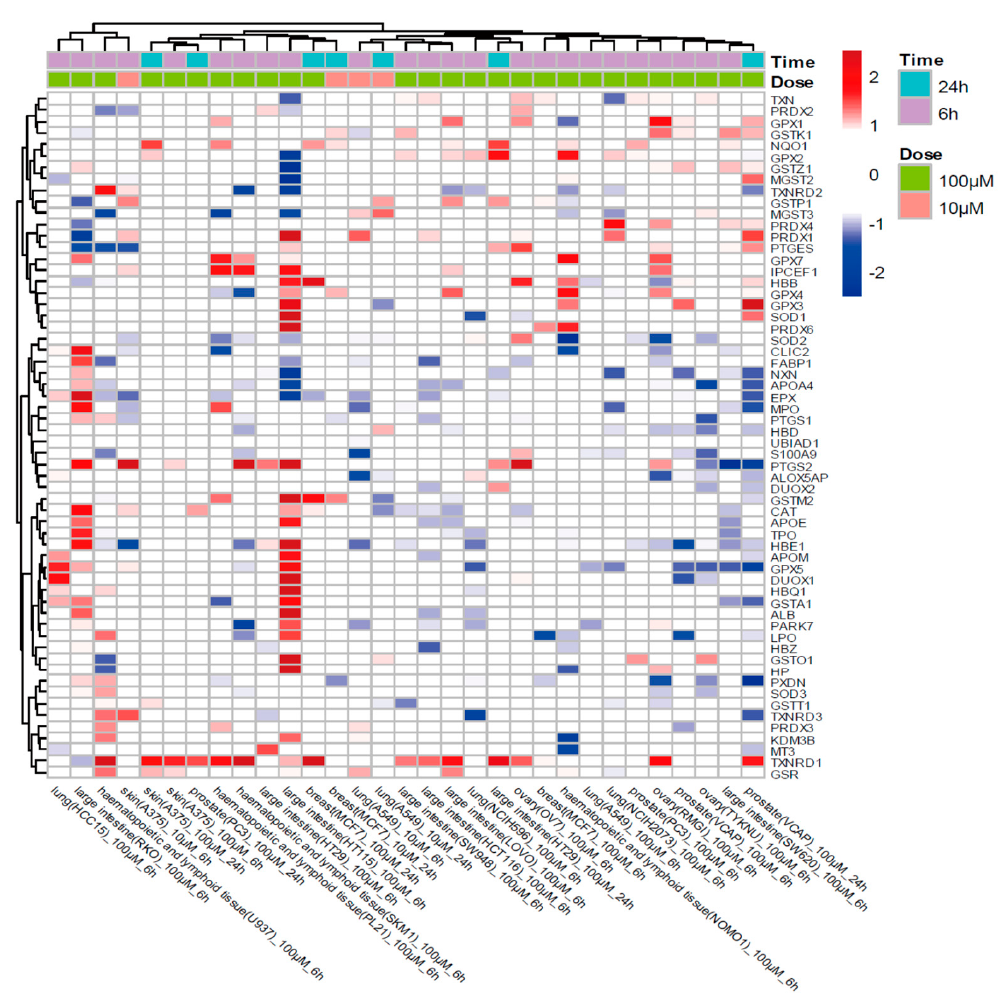
Figure 5. Connectivity Map data of necrostatin-1. Necrostatin-1-induced expression changes in 60 genes related to antioxidant activity. The antioxidant genes (GO:0016209) were collected from Gene Ontology Resource (http://geneontology.org/; created date: 27 January 2021).